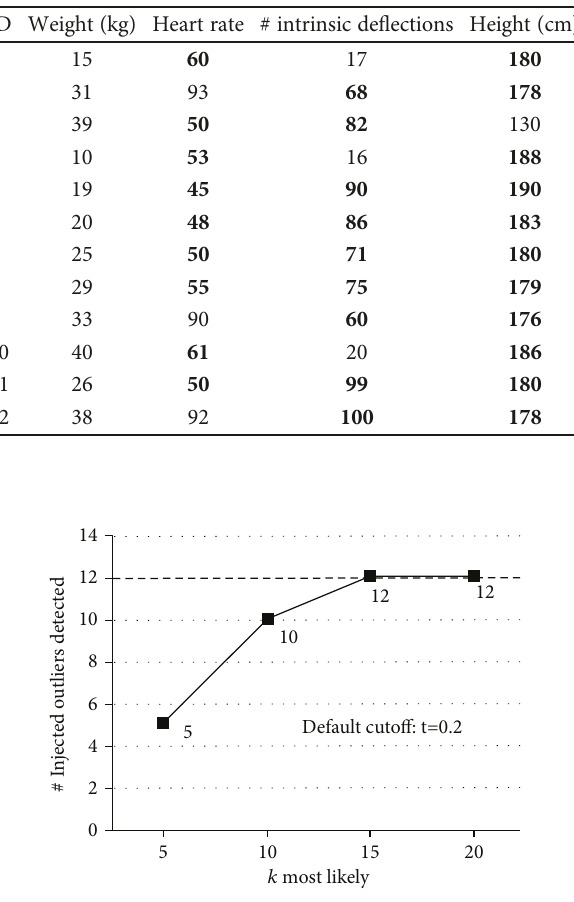
Figure 6: Number of injected outliers found between the k elements with the highest outlier probability.